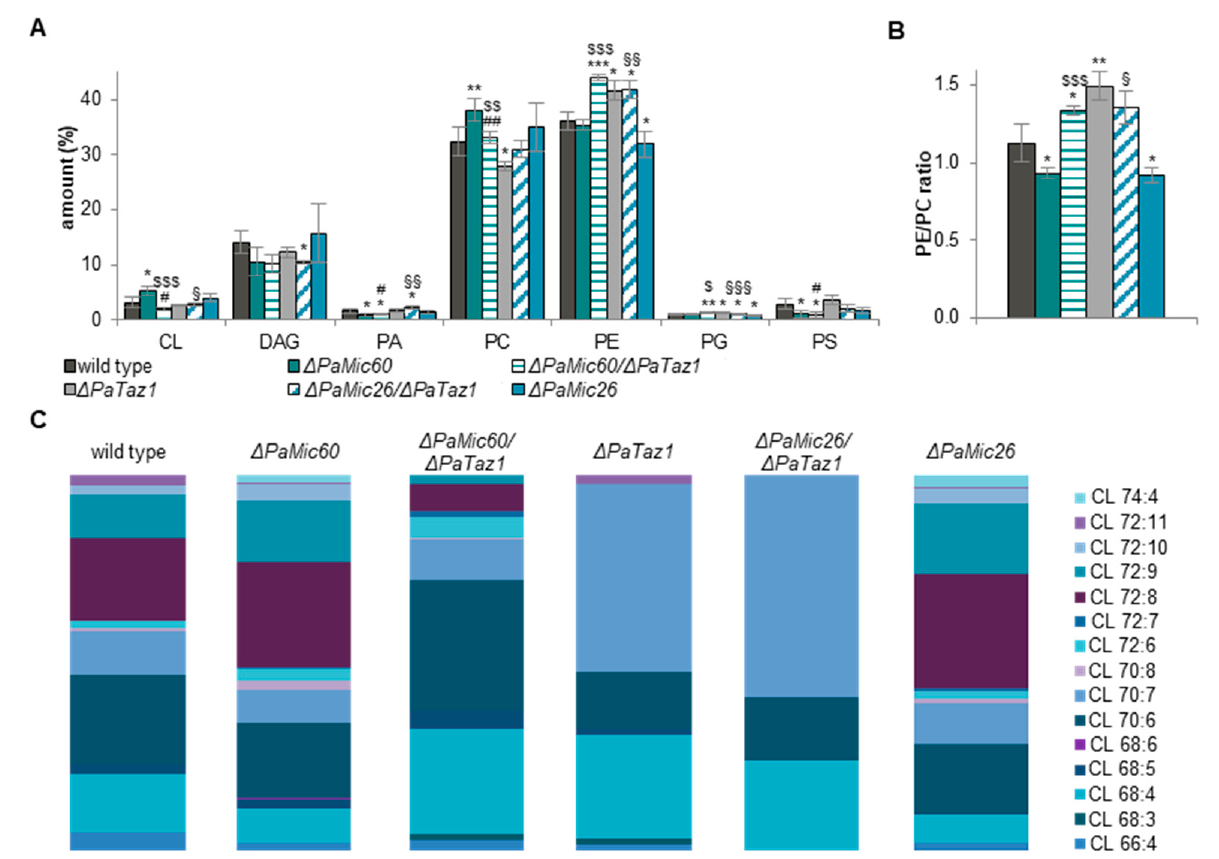
Figure 5. Simultaneous ablation of PaMIC60 and PaTAZ1 results in PaTAZ1-independent CL 72:X formation. ( A ) Phospholipid composition of the CDP-DAG pathway using mitochondrial protein extracts of P. anserina wild type ( n = 5), ∆ PaMic60 ( n = 5), ∆ PaMic60 / ∆ PaTaz1 ( n = 3), ∆ PaTaz1 ( n = 3), ∆ PaMic26 / ∆ PaTaz1 ( n = 3), and ∆ PaMic26 ( n = 5). Data represent mean ± SD. Exact values are shown in Supplementary Materials (Table S1). CL: cardiolipin; DAG: diacylglycerol; PA: phosphatidic acid; PC: phosphatidylcholine; PE: phosphatidylethanolamine; PG: phosphatidylglycerol; PS: phos- phatidylserine. ( B ) PE/PC ratio of cultures from ( A ). Data represent mean ± SD. ( C ) Graphical illustration of different CL species in wild type, Δ PaMic60 , Δ PaMic60 / Δ PaTaz1 , Δ PaTaz1 , Δ PaMic26 / Δ PaTaz1 , and Δ PaMic26 according to total length of all four acyl chains (66–74) and total degree of unsatura- tion (3–11). The most abundant CL species are represented. Exact values are shown in Supplemen- tary Materials (Table S2). Significant differences to wild type: * p < 0.05, ** p < 0.01, *** p < 0.001; # significant differences to Δ PaTaz1 : # p < 0.05, ## p < 0.01; significant differences to Δ PaMic60 : $ p < 0.05,